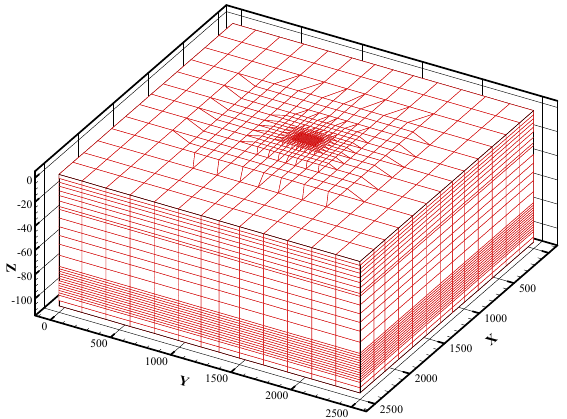
Figure 5. Three − dimensional model domain and the grid mesh. Figure 5. Three-dimensional model domain and the grid mesh.